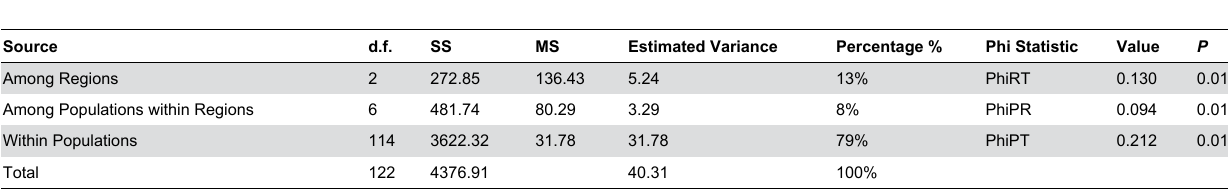
Table 4. Summary of the AMOVA results for 123 specimens of P. eryngii var. tuoliensis .